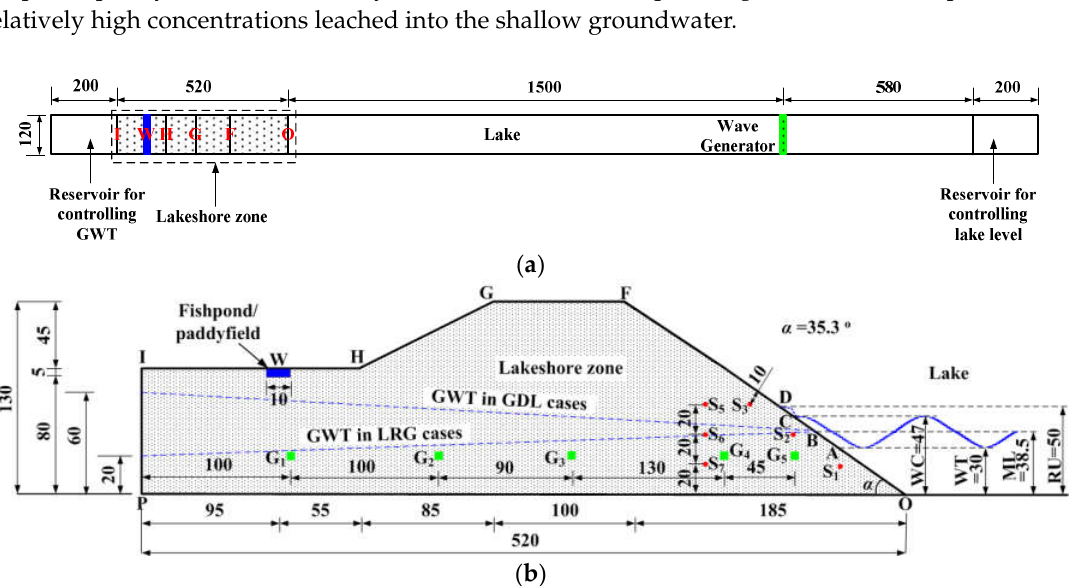
Figure 1. Schematic view of the experimental set up and positions of observation points. All units are in cm. (GWT, ground water table; WT, a wave trough height (point A), 30.0 cm; ML, a mean lake level height (point B), 38.5 cm; WC, a wave crest height (point C), 47 cm, and RU, a run-up height (point D), 50 cm, respectively; point W, a hypothetical pollution source representing a fishpond/paddyfield). ( a ) Plan view of the experimental set-up; ( b ) Side view of the lakeshore zone (observation points for solute concentrations ( ● : S 1 –S 3 and S 5 –S 7 ) and groundwater table (GWT, ■ : G 1 –G 5 )). GDL, groundwater discharging into a lake; LRG, lake water recharging groundwater.